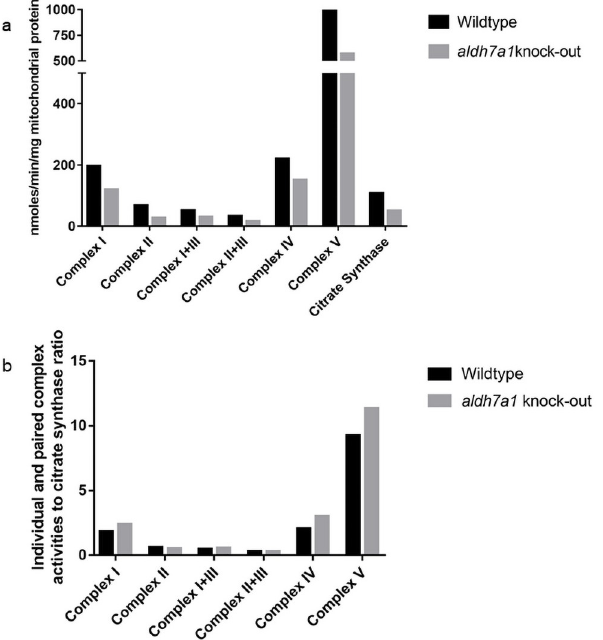
Fig 5. A & B. Quantification of fold change in the electron transport chain enzyme activities in knock-out aldh7a1 11 dpf embryos relative to the wildtype age-matched controls. Electron transport chain enzyme activities are reduced in aldh7a1 knock-out zebrafish. 5A: individual and paired complexes and citrate synthase. 5B: ratio of individual and paired complexes to citrate synthase. Bar graph of the quantification of fold change in the electron transport chain enzyme activities in knock-out aldh7a1 11 dpf embryos (grey bars) relative to the wildtype age- matched controls (black bars). Each bar represents data collected from 300 embryos. The activity of each enzyme was measured in presumed homozygous 300 and 300 wildtype embryos. The values are depicted as enzyme activity in nmol/min/ mitochondrial protein mass normalized to the activity of citrate synthase (For further details please refer to Materials and